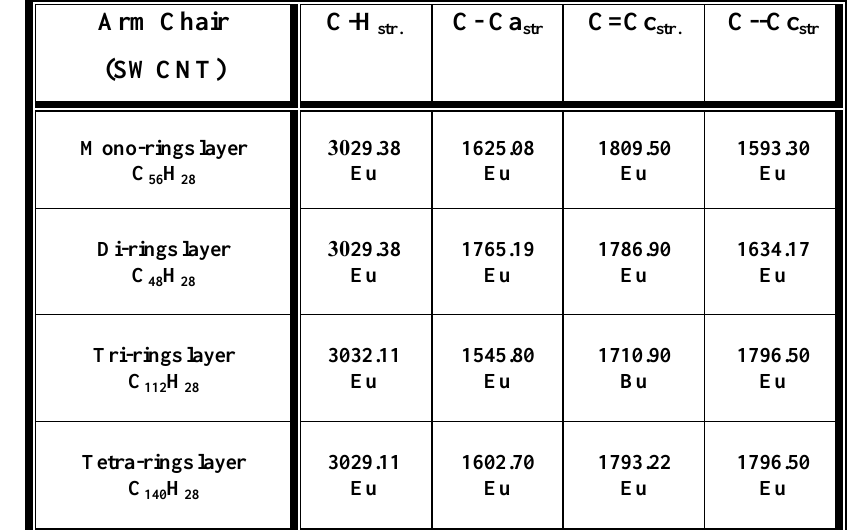
Table 7: Calculated Vibration frequencies of (mono, di, tri and tetra) rings layer for (7,7) armchair SWCNT applying G03 program by PM3 method.